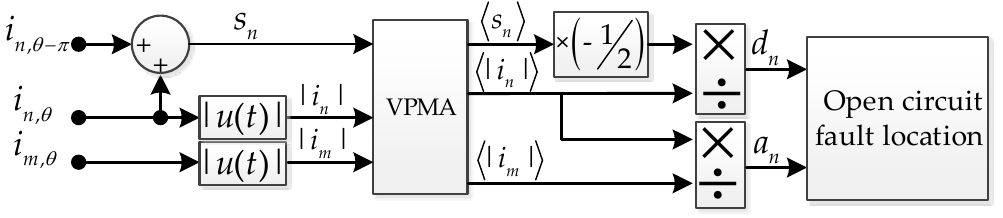
Figure 3. Diagram of realization of proposed algorithm.